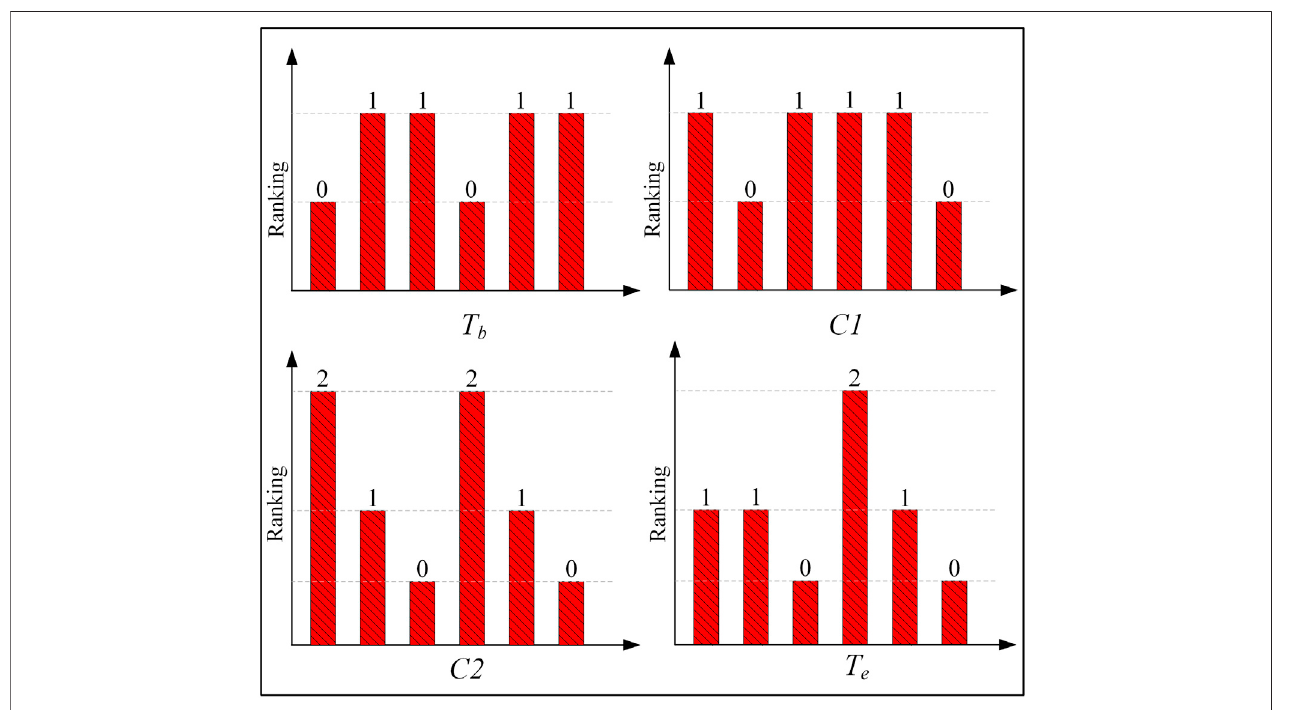
FIGURE 9 | Code diagram of electrical continuity loss defect code diagram of three-leaf layout cable